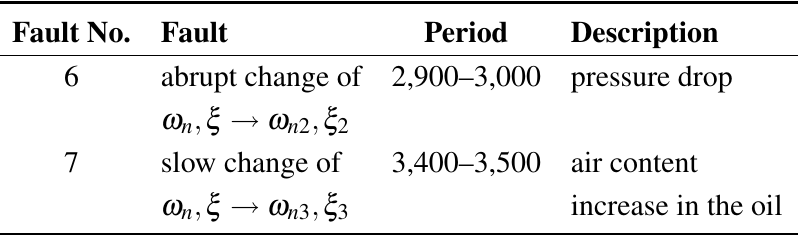
Table 2. List of actuator